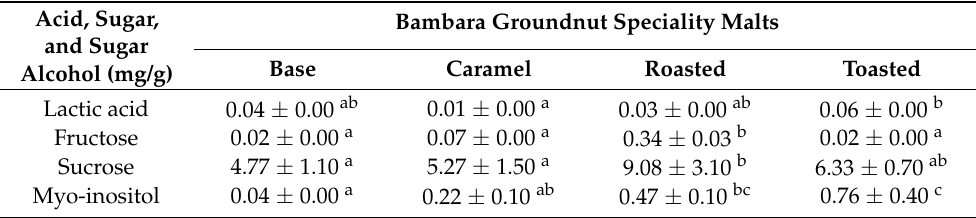
Table 9. Acid, sugars, and sugar alcohol concentration of speciality Bambara groundnut malts 1 .